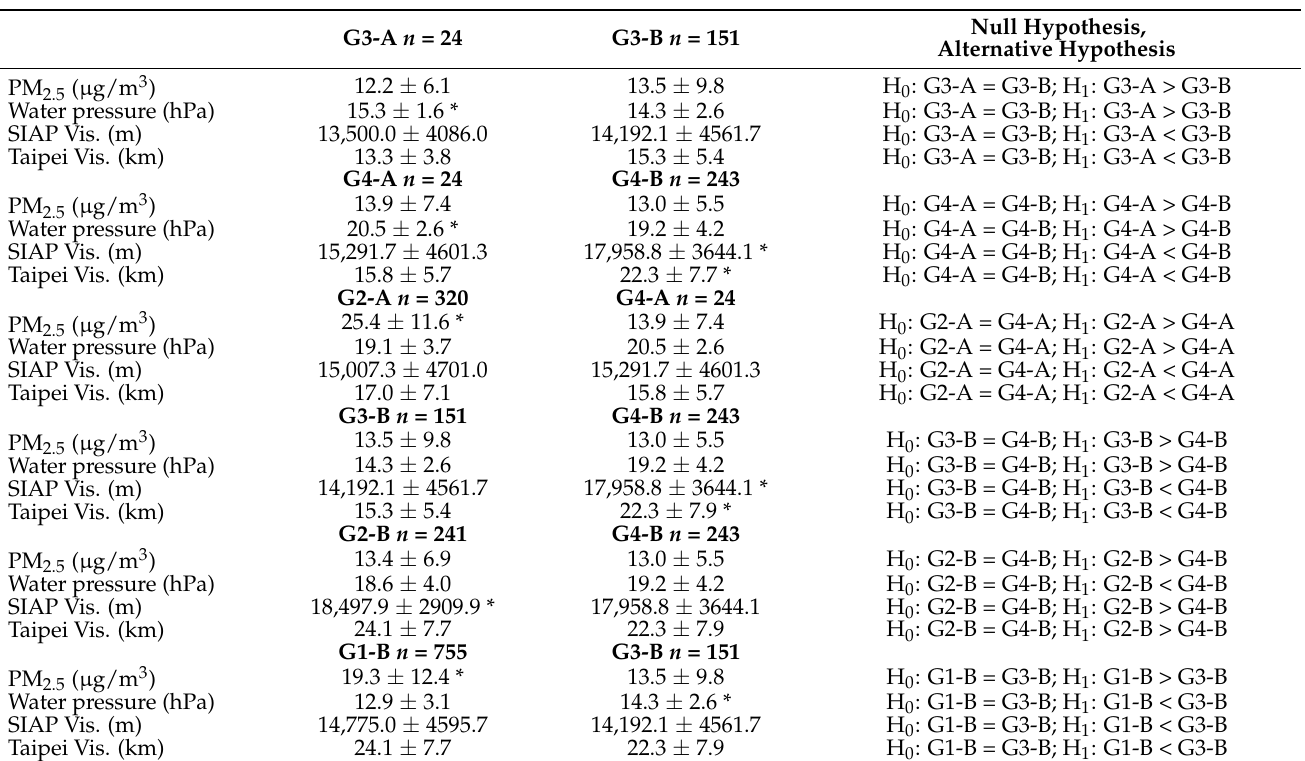
Table 6. Difference in the weather parameters between the groups under the conditions in Table 5 from 2016 to 2019 in the Taipei metropolis during the